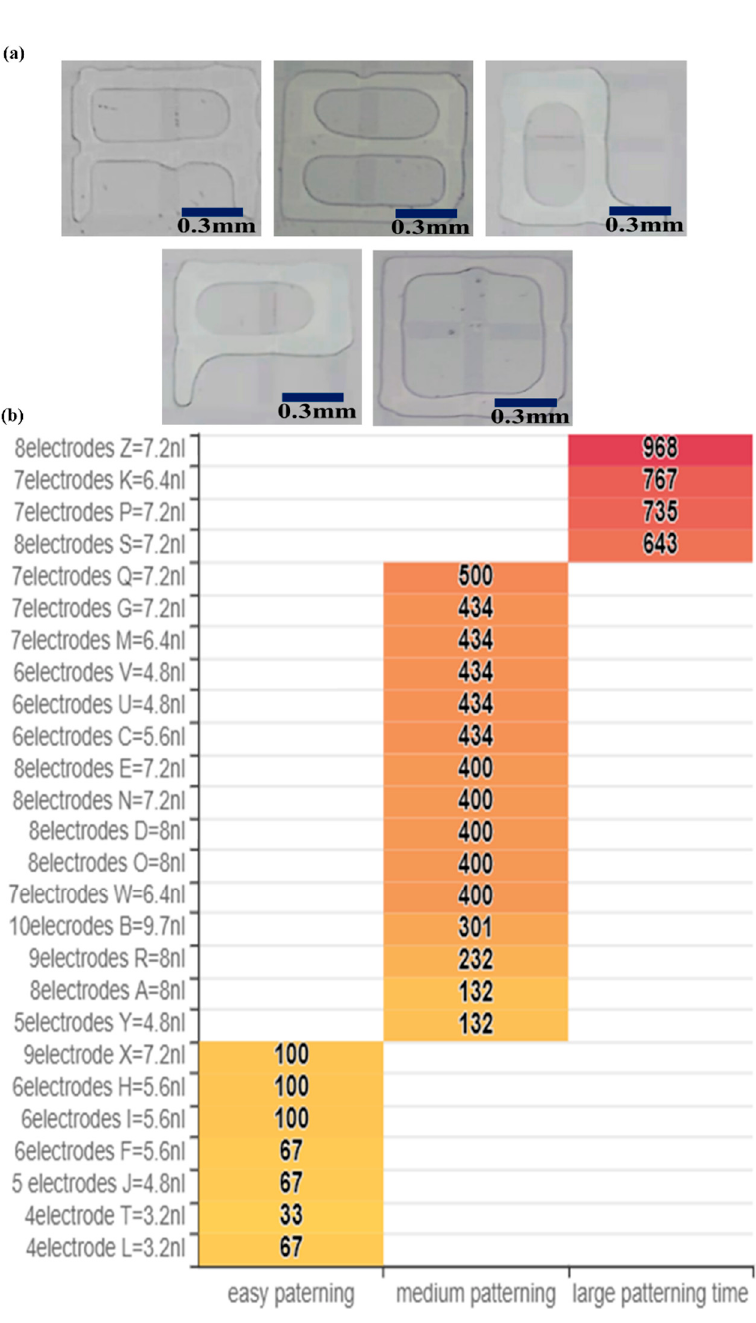
Figure 8. ( a ) Microfluidic patterning, A, B, Q, P, O at 140 Vpp/20 kHz and with 10 µ m gap height. ( b ) Amount of time and volume taken to form the letters A to Z.